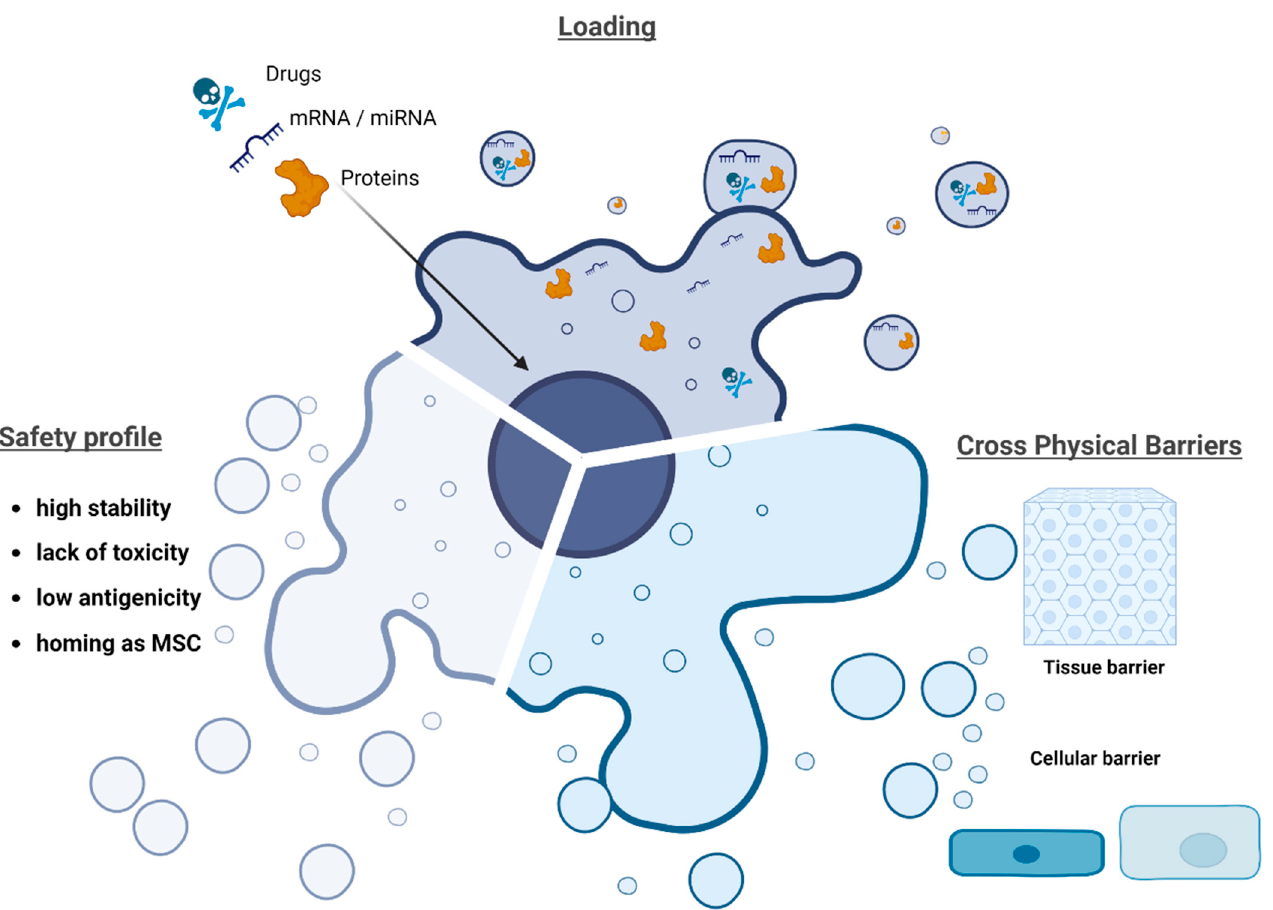
Figure 2. Advantages of extracellular vesicles (EVs) vs. liposomes. Loading cargos, safety profile, and their potential to cross barriers.